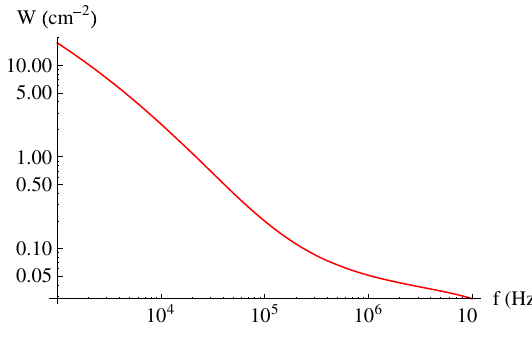
FIG. 5. Horizontal wake function, nominal